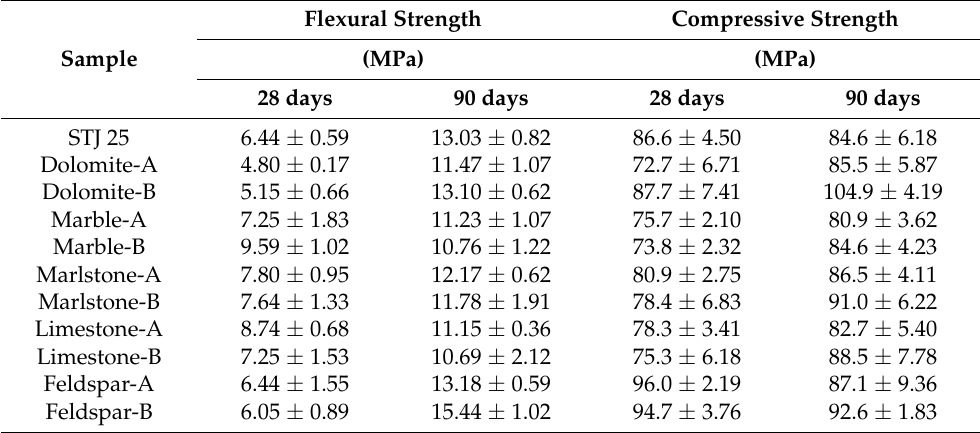
Table 4. The mechanical properties of geopolymer composites with different types of waste stone powder.